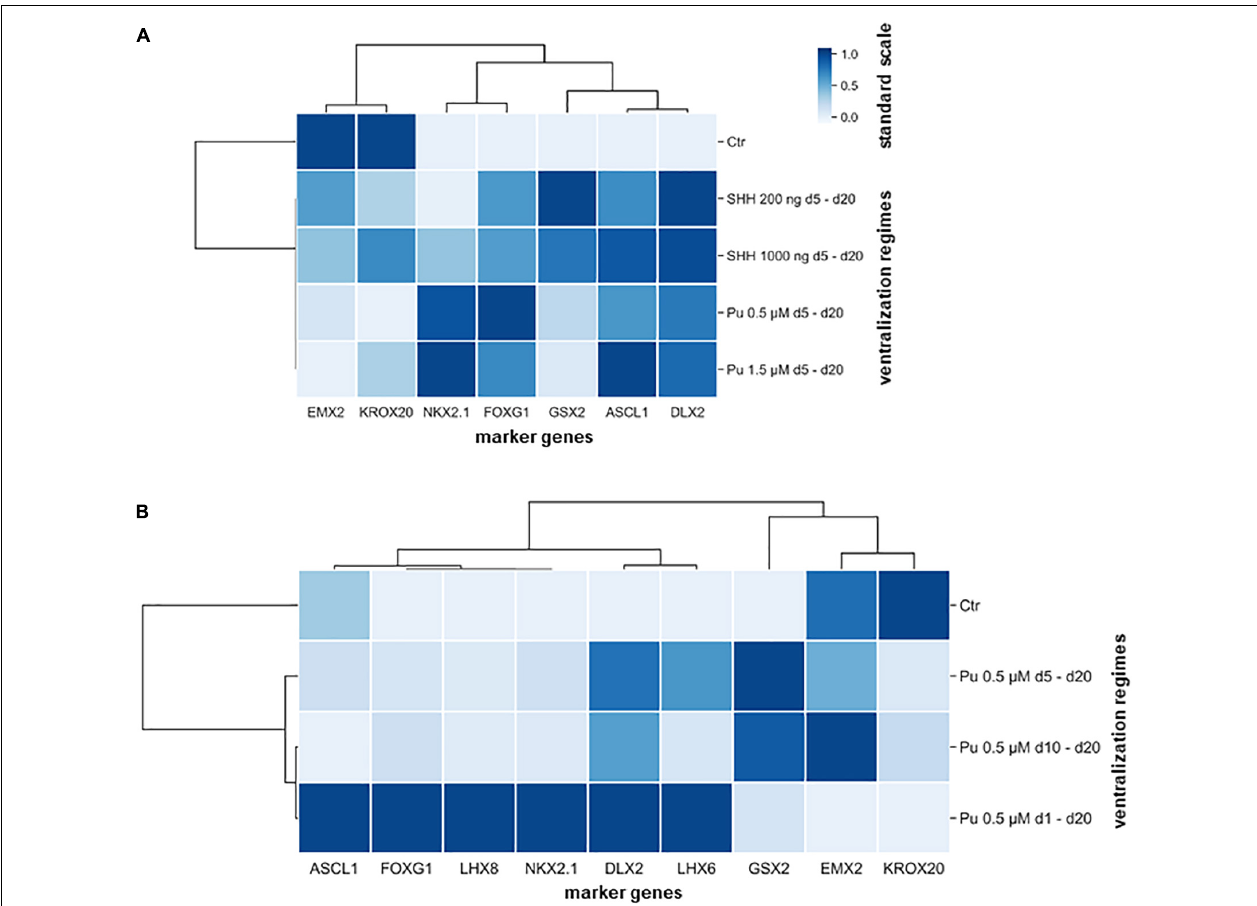
FIGURE 5 | Hierarchical cluster heatmaps segregating the gene expression profiles (transverse axis) from the expression signature (longitudinal axis) according to applied rostro-ventralization regimes. (A) The first cluster map is based on RT-qPCR datasets from the comparison between Pu vs. SHH. The gene expression profiles were clustered into four groups: most downregulated after Pu treatment (EMX2 and KROX20), most upregulated after Pu treatment (NKX2.1 and FOXG1), most upregulated after SHH 200 ng/ml administration (GSX2), and in general upregulated after rostro-ventralization (ASCL1 and DLX2). Furthermore, the ventralization regimens appeared to cluster by morphogen type rather than by applied concentration. (B) The second cluster map is based on RT-qPCR datasets from different Pu treatment intervals. Here, the gene expression profiles clustered in three major groups: most elevated after the earliest and longest purmorphamine administration (d1–d20) (forebrain, pan-GE, GABAergic, and MGE-specific markers), most upregulated after the intermediate purmorphamine (d5–d20) interval (LGE); most downregulated after the earliest and longest purmorphamine administration (d1–d20) (cortical and hindbrain). Likewise, the ventralization regimes clustered whether they promoted an MGE-like expression signature or resulted in an LGE-like identity. The standard scale was calculated for each gene